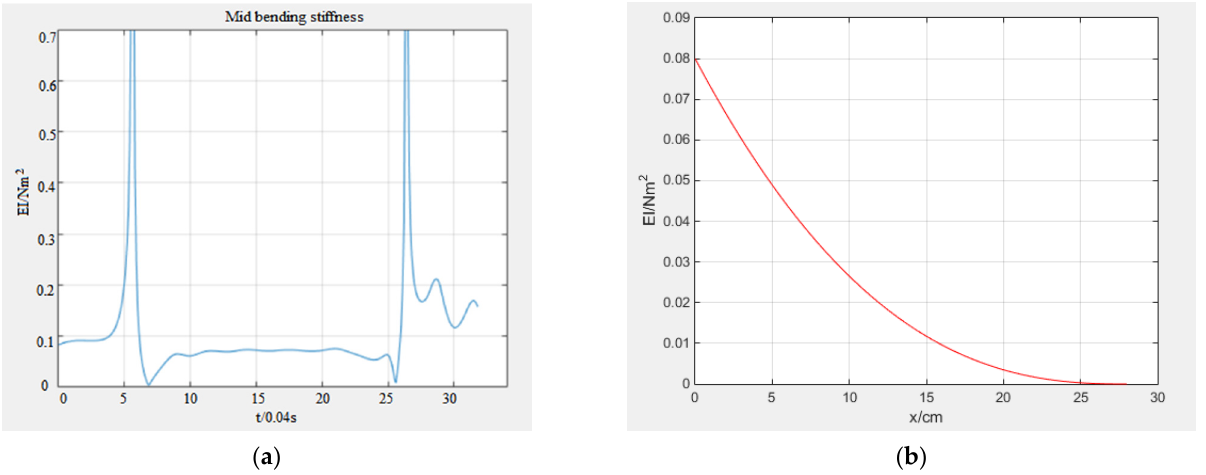
Figure 4. The bending stiffness of tuna tail. ( a ) Stiffness—time curve of fish tail end. ( b ) Calculated stiffness curve of fish tail.